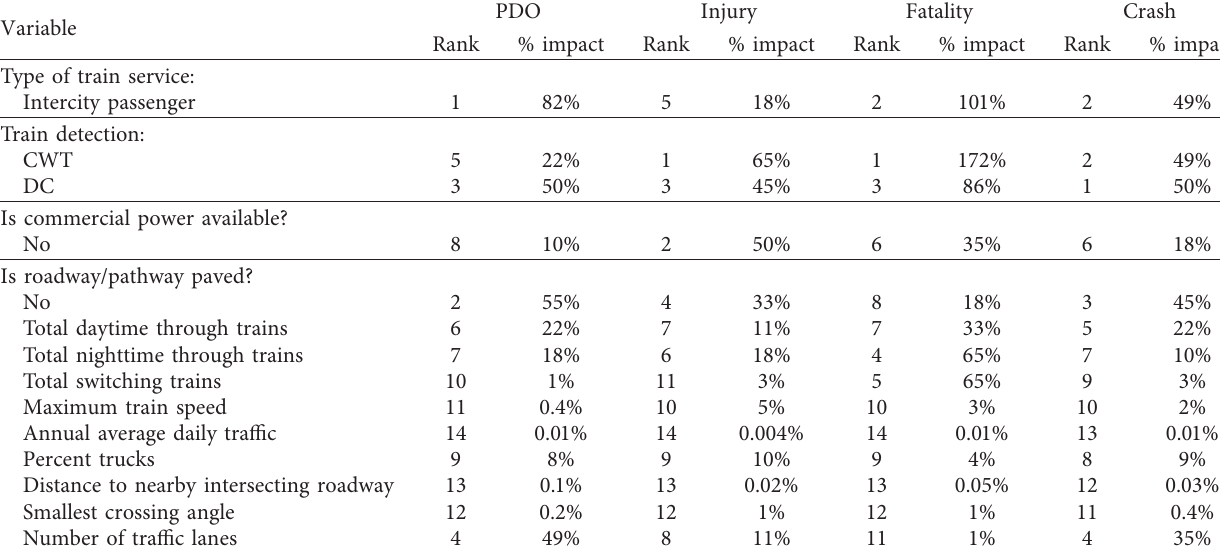
Table 3: Ranking variables based on hazard